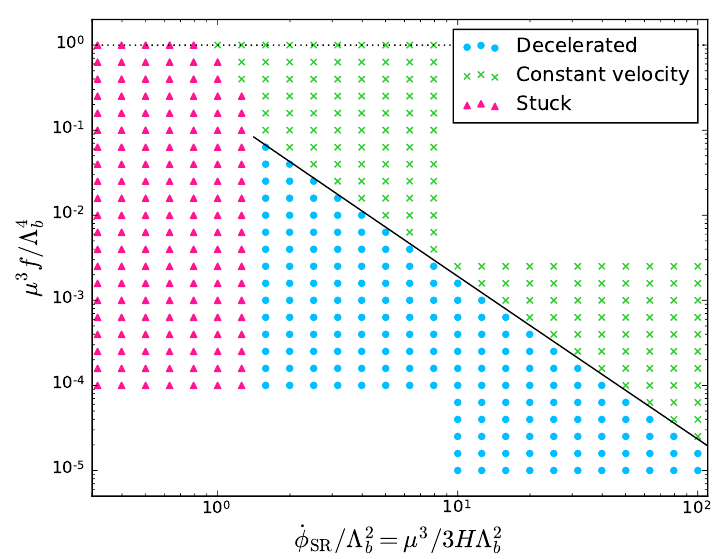
Figure 15 . Phase diagram of axion particle production e(cid:11)ect with H 6 = 0. The initial velocity is taken to be the slow roll velocity (cid:22) 3 = 3 H . Blue: particle production is e(cid:14)cient enough to stop the axion rolling. Green: the velocity of the axion is (cid:12)xed to the slow roll velocity. Red: the initial kinetic energy is not large enough to overcome the (cid:12)rst barrier. The black line shows the condition in eq. (3.31), which reproduces the boundary between the blue and the green regions.